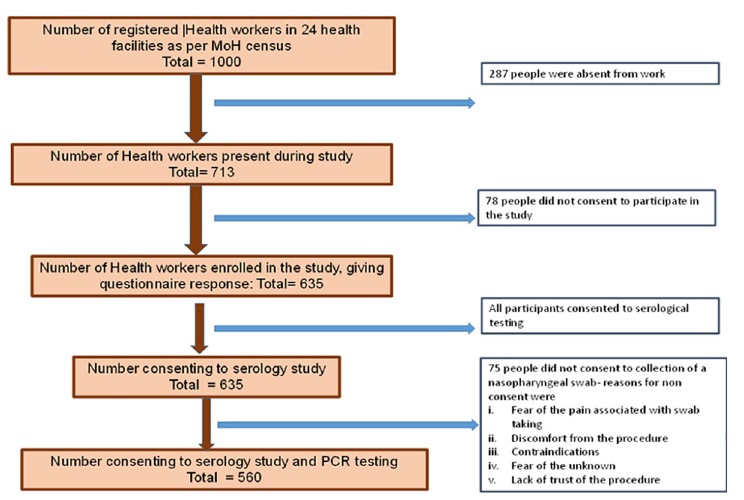
Fig 2. Summary of the study participant sample